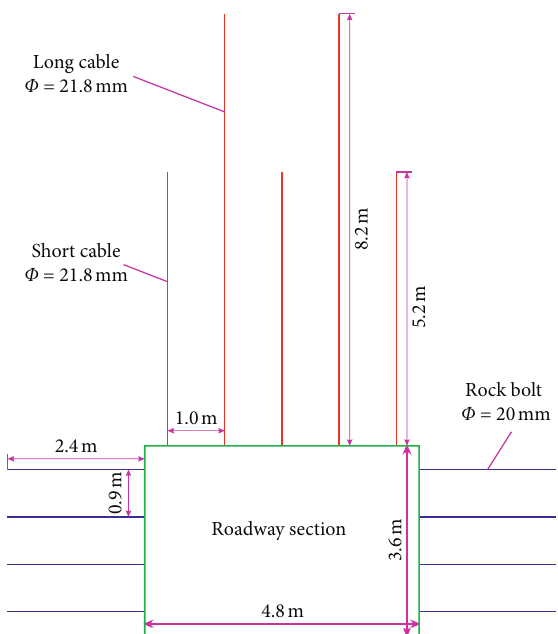
Figure 10: Support scheme for the 13313 return airway.